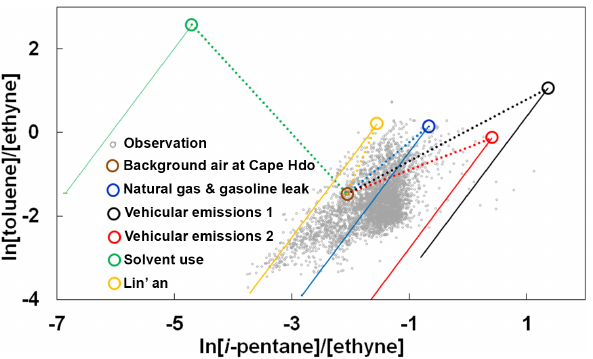
Figure 8. Scatter plot of hourly averaged f 44 (black dot) as a function of photochemical age, t [OH], estimated by means of the NO x / NO y clock (the bottom x axis) and a linear regression (gray line). As comparison, f 44 binary mixing models (dotted curves) of HOA and LV-OOA using different combinations of model parame- ters (combination I (green), combination II (blue), and combination III (red)) are also shown. See the text for the detail of the combina- tions of model